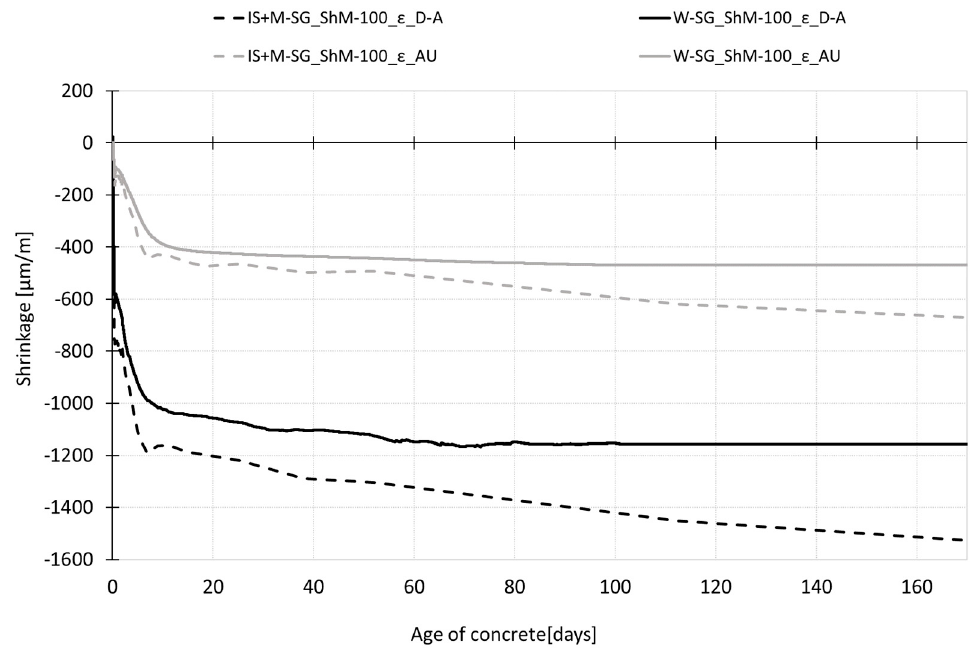
Figure 8. The overall process of shrinkage ( ε ) recorded during the whole time of measurement for specimens cured under dry air and autogenous conditions.